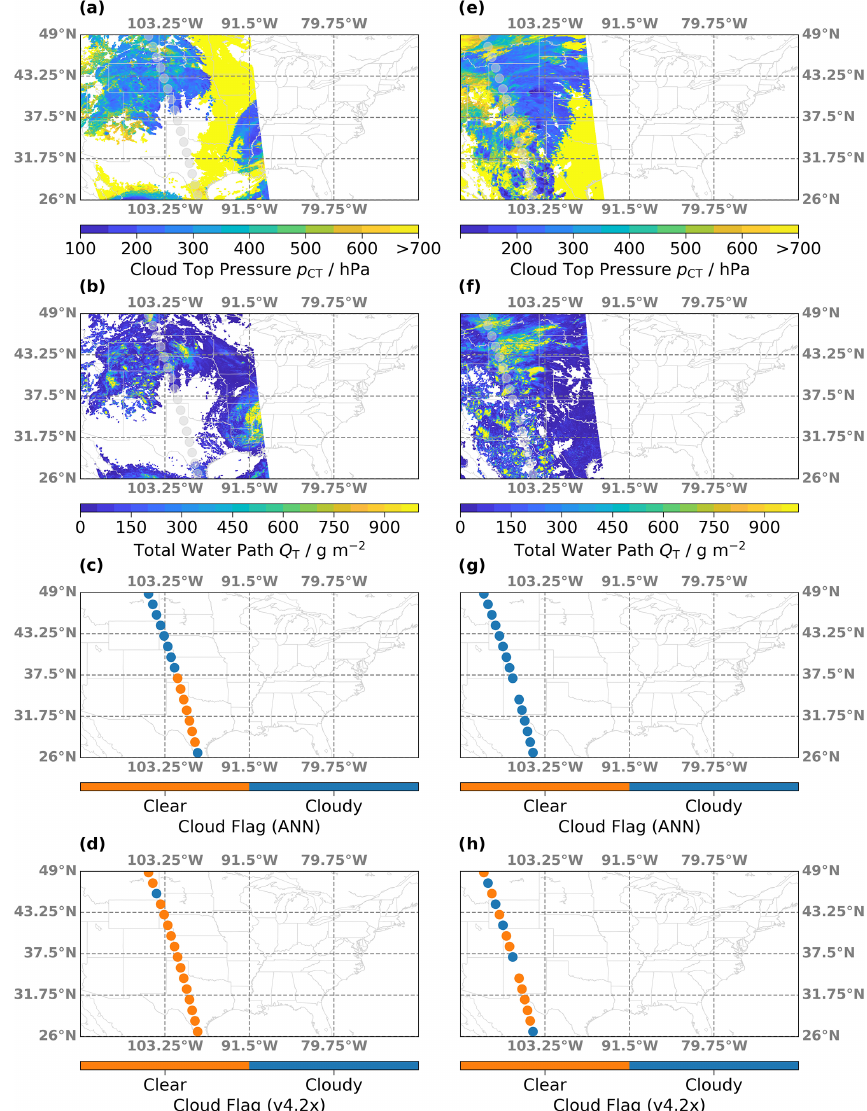
Figure 8. (a) Map of cloud top pressure ( p CT ) retrieved from MODIS observations on 31 August 2017 over North America. Transparent circles indicate the MLS orbit. (b) Similar to (a) but for the total water path ( Q t ). (c) Clear (orange) and cloudy (blue) profiles as determined from the new ANN algorithm. (d) Same as (c) but determined from the current v4.2x status flags. (e–h) Same as (a–d) but for MLS and MODIS observations on 5 July